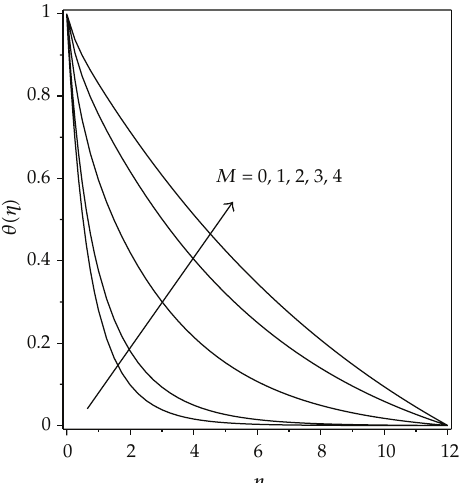
Figure 2: Temperature profiles for di ff erent values of M when Pr (cid:9) 0 . 78, Sc (cid:9) 0 . 6, D f (cid:9) 0 . 03, S r (cid:9) 2, r (cid:9) 0, and f 0 (cid:9)